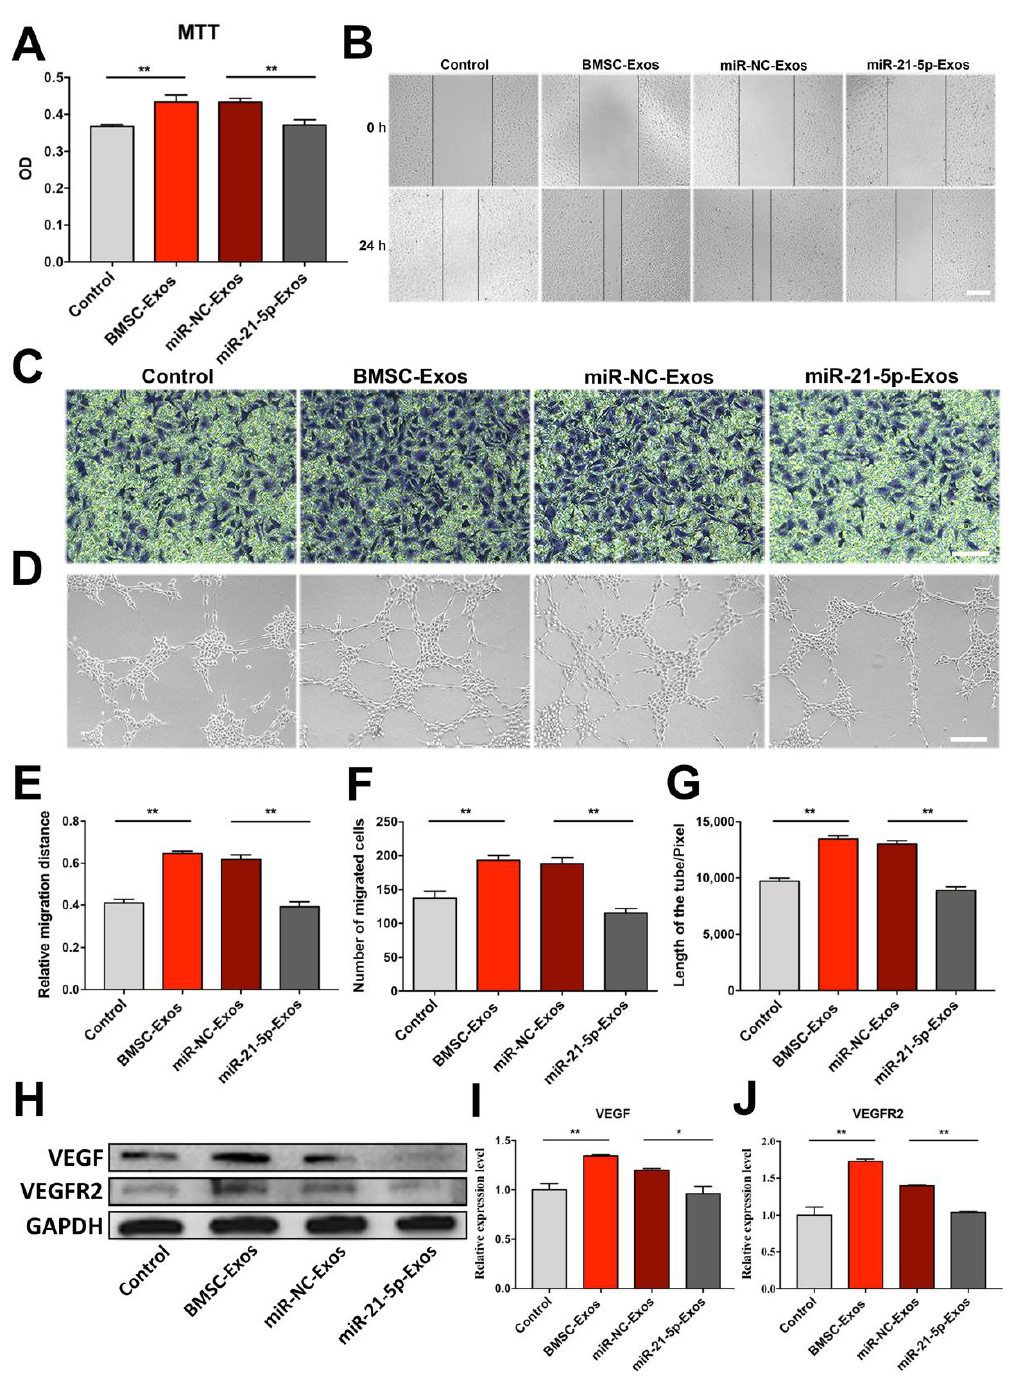
Figure 9. BMSC-Exos promoted proliferation, migration, and tube formation of HUVECs via upreg- ulation of miR-21-5p. ( A ) Cell viability of HUVECs cocultured with miR-21-5p- or miR-NC-Exos. n = 6/group. ** p < 0.01. ( B ) Representative images of scratch assay for migration of HUVECs. Scale bar = 200 μm. ( C ) Representative images of Transwell assay for HUVECs migration. Scale bar = 100 μm. ( D ) Representative images of tube formation of HUVECs. Scale bar = 200 μm. ( E ) Measurement of relative migration distance. n = 3/group. ** p < 0.01. ( F ) Number of migration cells in Transwell assay. n = 3/group. ** p < 0.01. ( G ) Total length of tube formed by HUVECs. n = 3/group. ** p < 0.01. ( H – J ) Western blot analysis and quantification of densitometries of Western blot band. n = 3/group. * p < 0.05. ** p < 0.01. MTT, 3-(4,5-dimethyl-2-thiazolyl)-2,5-diphenyl-2-H-tetrazolium bromide; OD,